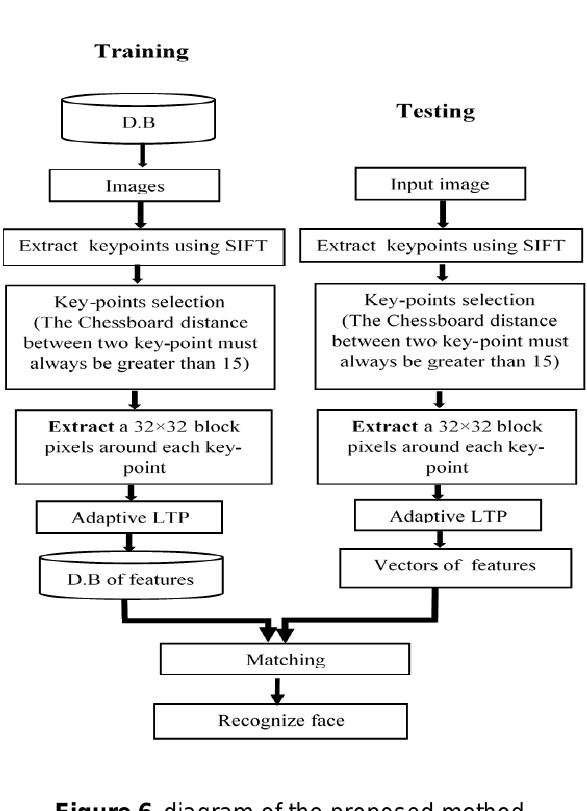
Figure 6. diagram of the proposed